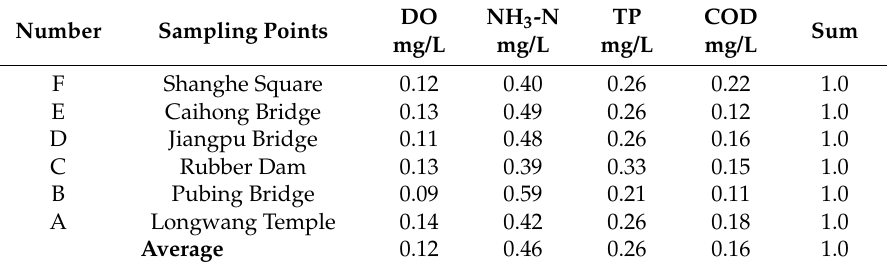
Table 9. The calculation results of weight coefficient of six sections after treatment.